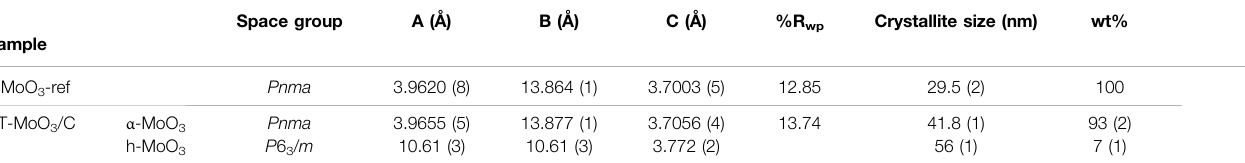
TABLE 2 | Rietveld re fi nement parameters of MoO 3 and HT-MoO 3 /C samples.